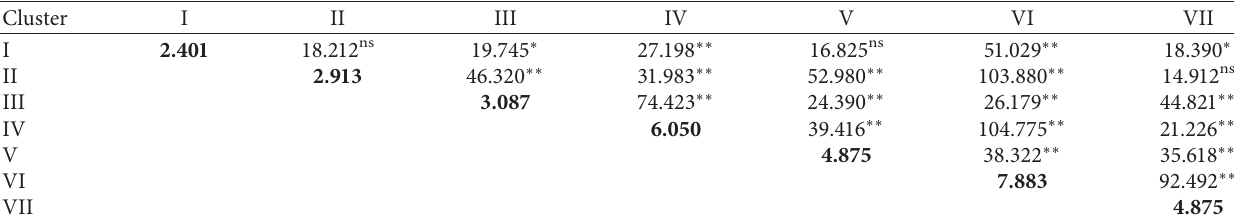
Table 6: Average intra- (bold) and inter-cluster divergence value for bread wheat accessions